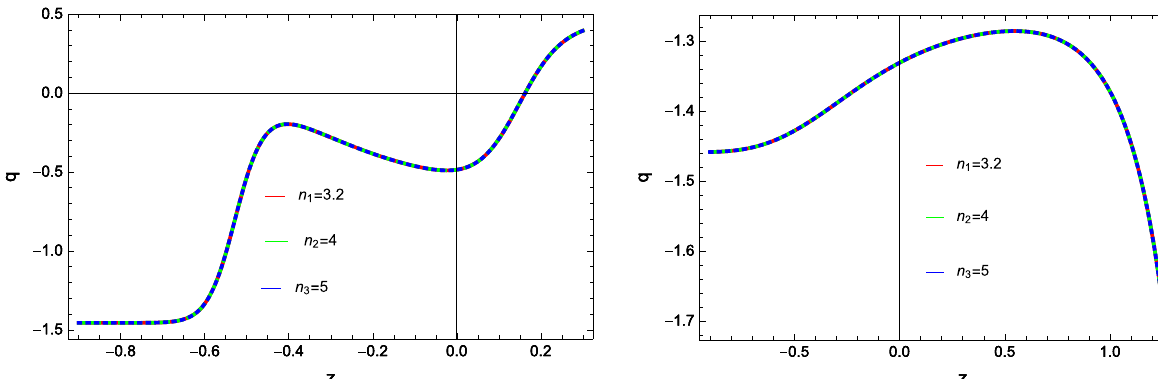
Fig. 4 Plots of power-law deceleration parameter q for u = 2 (left) and − 2 (right)